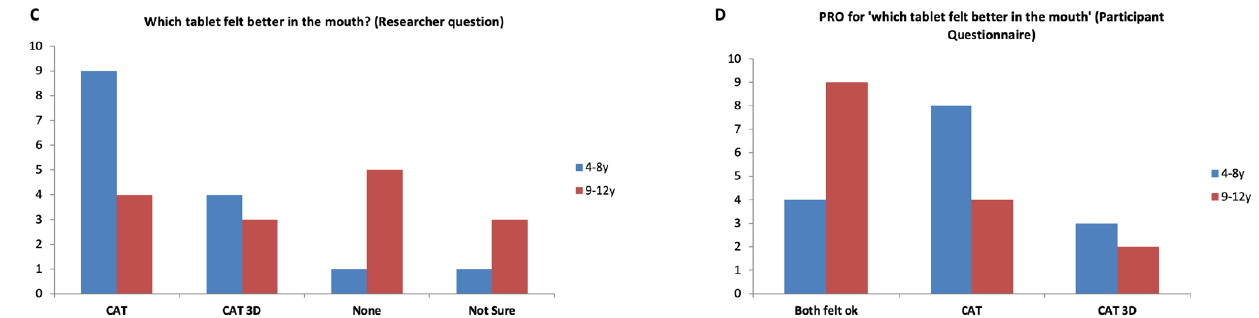
Figure 7. PRO score for ‘if this was a medicine would you take it every day?’ in ( A ) 4–8-year-olds, and ( B ) 9–12 years old, ( C ) Which tablet felt better in the mouth? (Researcher question), and ( D ) ‘Which tablet felt better in the mouth?’ for participants aged 4–8 and 9–12 years.